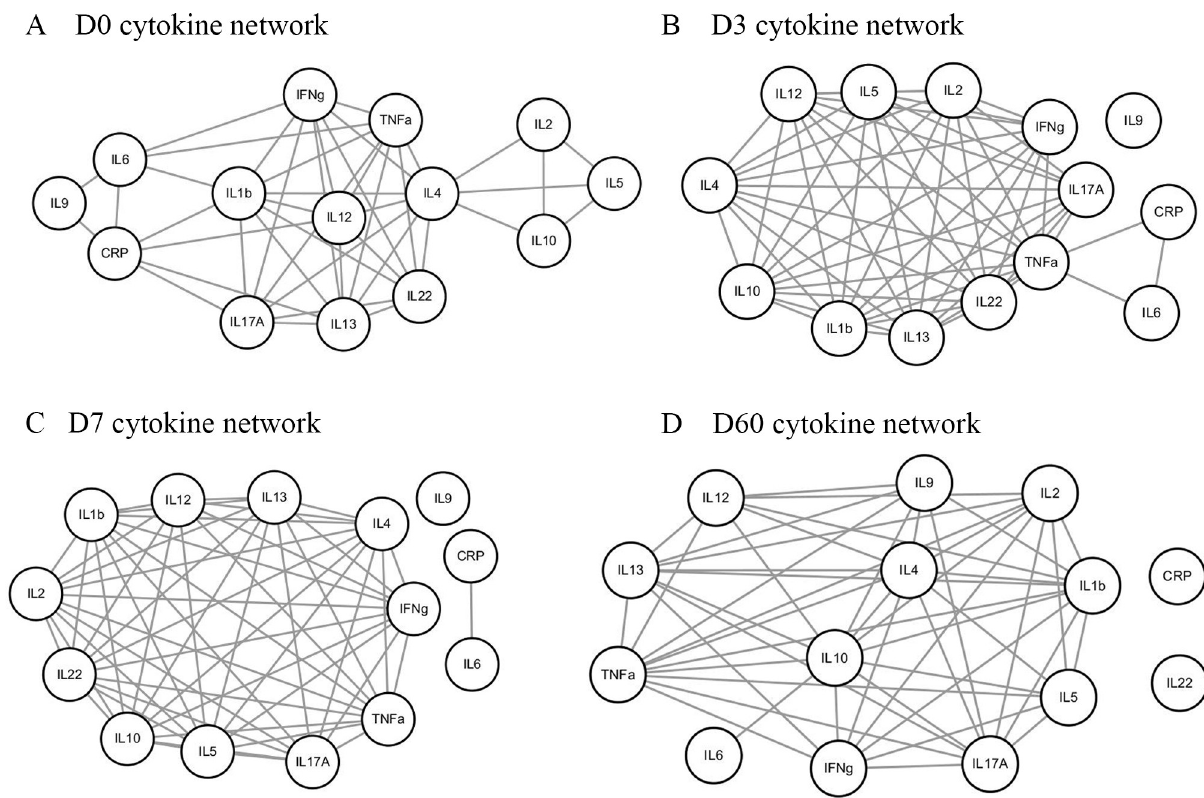
Fig 2. Cytokine Network of hepatocellular carcinoma after TACE. Network analysis results at (A) D0, (B) D3, (C) D7 and (D) D60 after transarterial chemotherapy are presented.